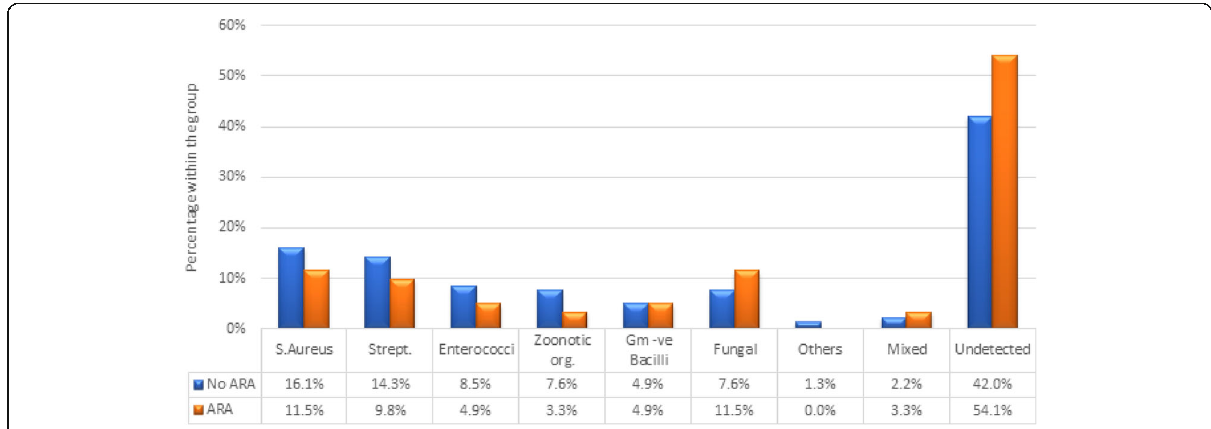
Fig. 3 Causative organisms in ARA and No-ARA